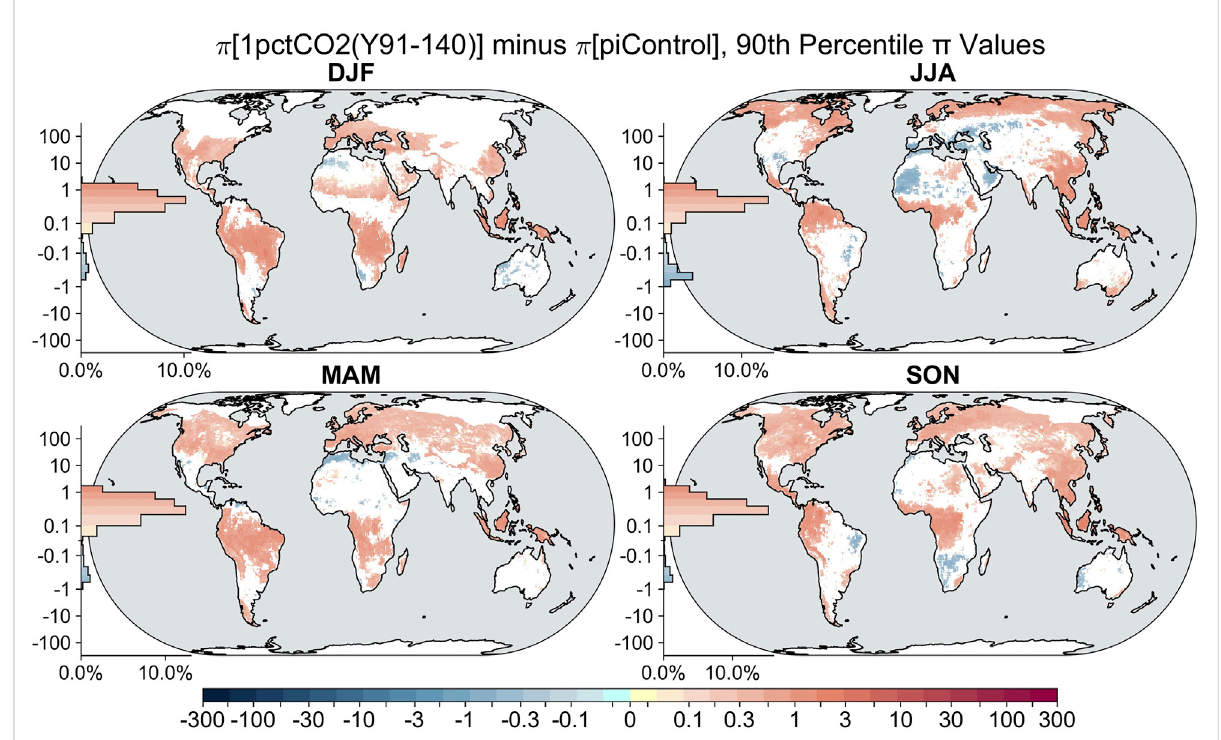
FIGURE 7 Multimodel median of differences in the 90th percentile values of π (dimensionless) for the period of 1pctCO2 approaching quadrupled CO 2 minus piControl for each season. Areas are masked where the agreement among models on the sign of the change is below the 99% con fi dence level, or where the median of seasonal mean near-surface air temperature is below 0 ° C. Histograms show the probability distribution of signi fi cant changes as a fraction of the total land